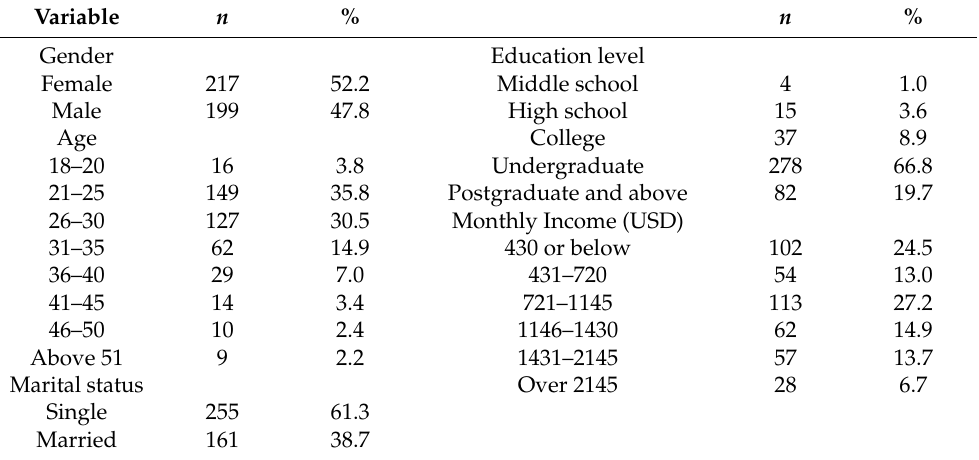
Table 1. Demographic profile ( n =